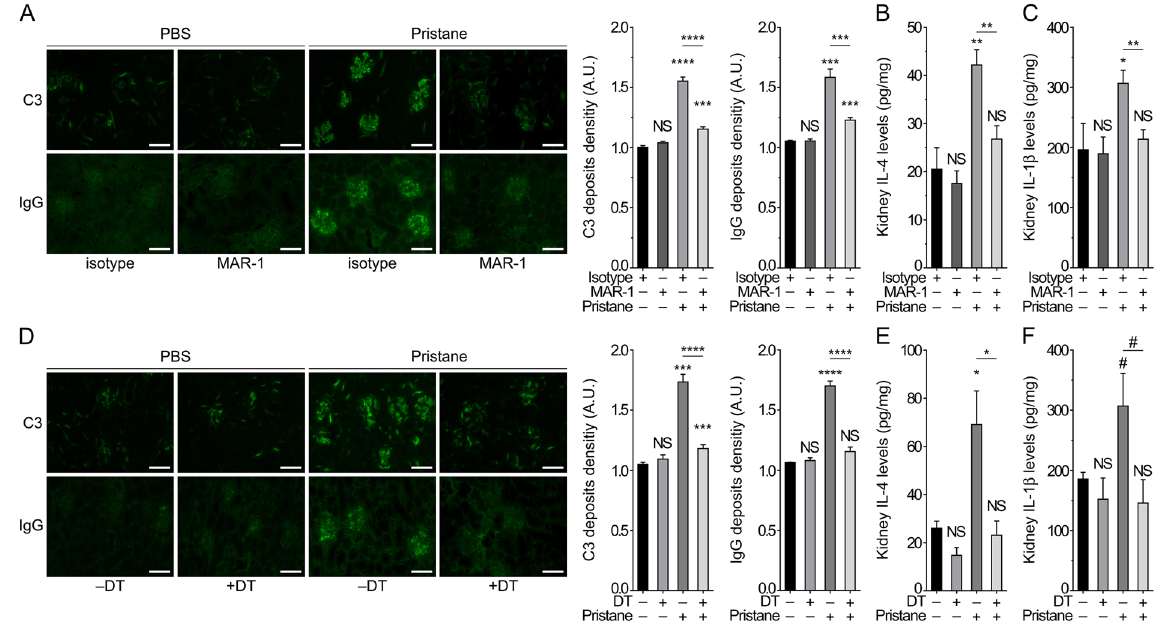
Figure 4. Basophil depletion dampens pristane-induced kidney disease. ( A , D ) Representative immunofluorescence staining for C3 and IgG deposits in kidneys from mice treated as indicated and the corresponding quantifications in mice as described in Fig. 2. Scale bar = 500 µ m. ( B , C , E , F ) Levels of IL-4 ( B , E ) and IL-1 β ( C , F ) in total kidney protein extracts from mice as described in Fig. 2 and as assessed by ELISA. Data are presented as mean + s.e.m. Statistical analyses were by unpaired Student t tests. NS, not significant; * p < 0.05, ** p < 0.01, *** p < 0.001, **** p < 0.0001. # p < 0.1. A.U.: arbitrary